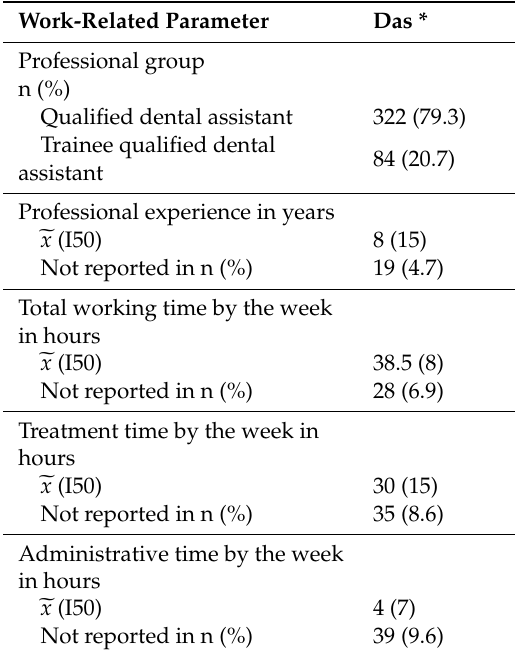
Table 2. Work -related characteristics of the study population.